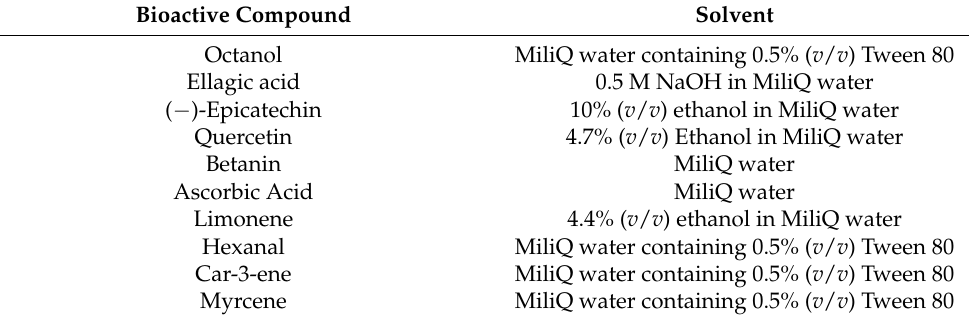
Table 1. Solvent concentrations in 0.5% ( w / v ) Flavor compound